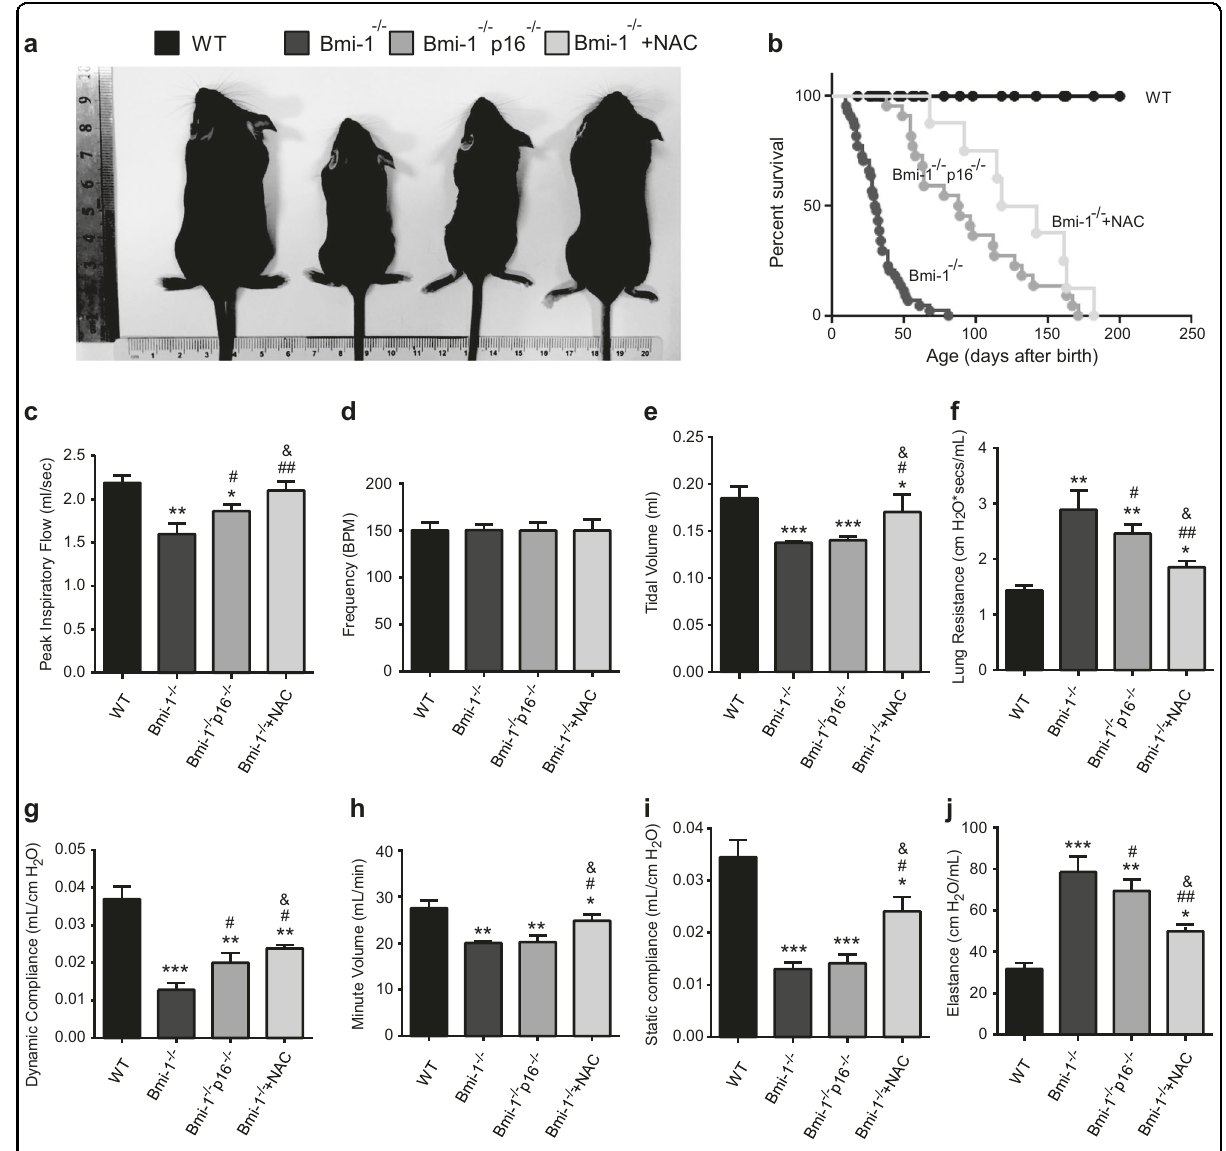
Fig. 1 NAC treatment improved premature senescence and pulmonary dysfunction in Bmi-1 − / − mice better than in Bmi-1 − / − p16 − / − mice. a Representative appearances of 7-week-old WT, Bmi-1 − / − , Bmi-1 − / − p16 − / − , and NAC-treated Bmi-1 − / − ( Bmi-1 − / − + NAC) mice. b Percent survival of the mice. Pulmonary function was detected by the Buxco measurement system and FinePointe analysis for c peak inspiratory fl ow, d frequency, e tidal volume, f lung resistance, g dynamic compliance, h minute volume, i static compliance, and j elastance. Six mice per group were used for experiments. Values are the means ± SEM of six determinations per group. * P < 0.05, ** P < 0.01, *** P < 0.001 compared with the WT group; # P < 0.05, ## P < 0.01 compared with the Bmi-1 − / − group; & P < 0.05 compared with the Bmi-1 − / − p16 − / −